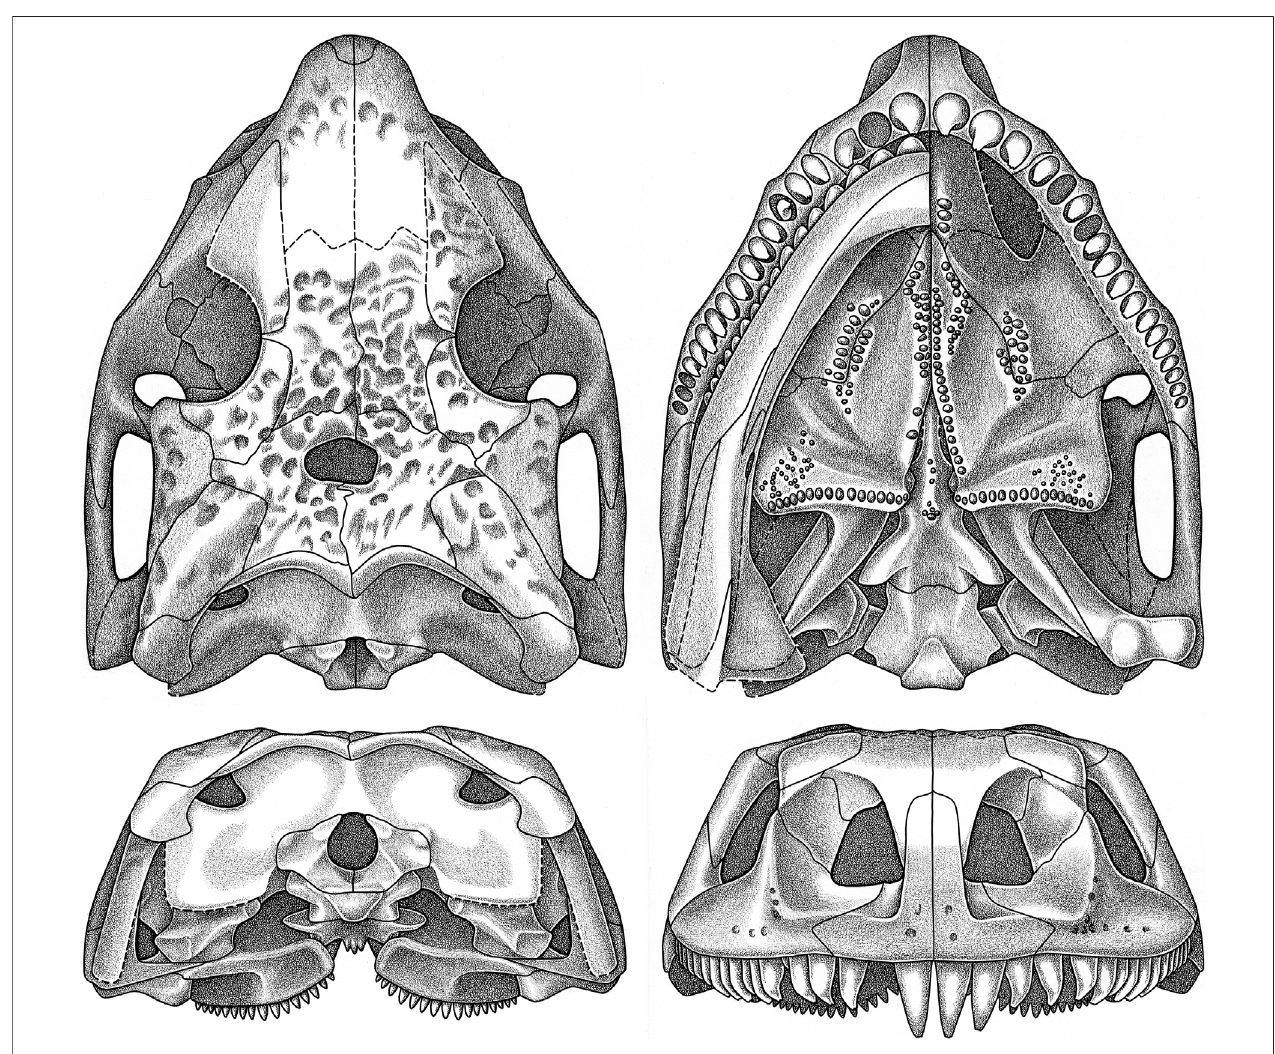
FIGURE 5 | Cotylorhynchus romeri . Skull reconstruction in dorsal, ventral, posterior and anterior views.